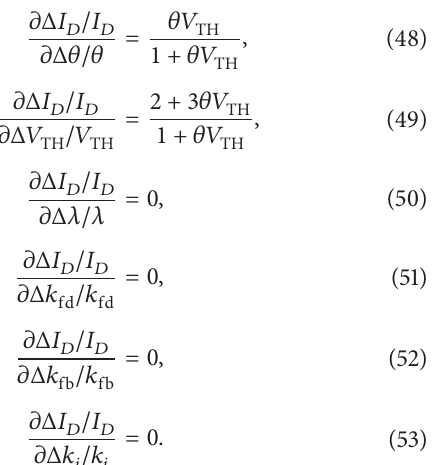
Figure 7: Equivalent circuit of FGMOSFET based transconductor which is the core circuit of FGMOSFET based VIC